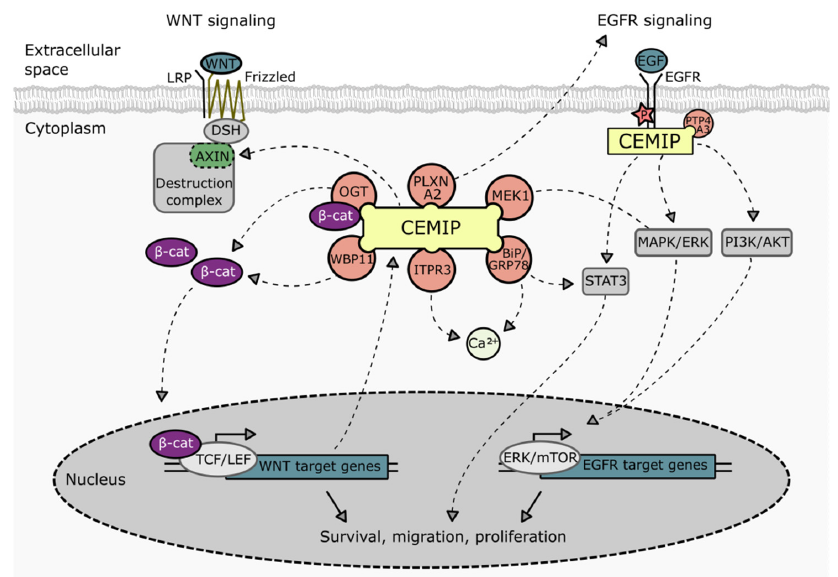
Figure 3. Schematic representation of the involvement of CEMIP in various signaling pathways. Direct interaction partners of CEMIP related to Wnt, EGFR, and Ca 2+ signaling pathways are indicated. BiP: binding immunoglobulin protein. ITPR3: 1,4,5-trisphosphate receptor type 3. MEK1: Mitogen-activated protein kinase kinase 1. OGT: O-GlcNAc transferase. PLXNA2: Plexin A2. PTP4A3: protein tyrosine phosphatase 4A3. WBP11: WW domain binding protein 11.